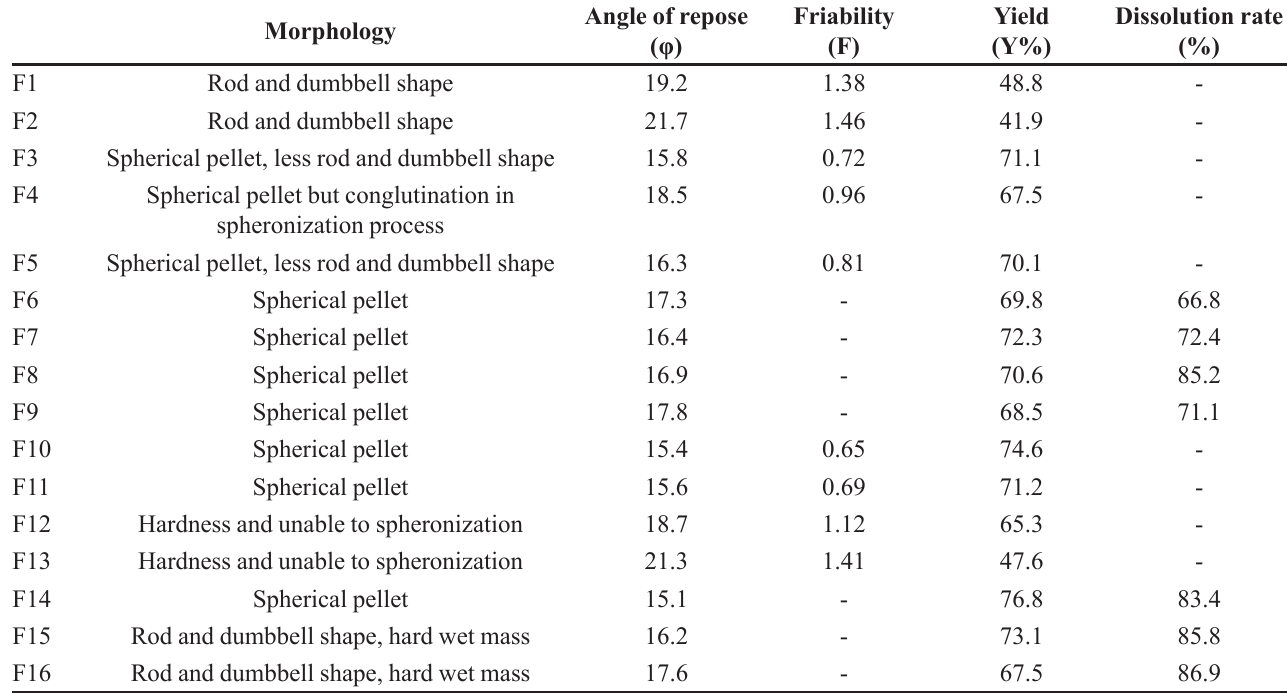
TABLE II - Micromeritic properties and dissolution rate of tacrolimus-SDP